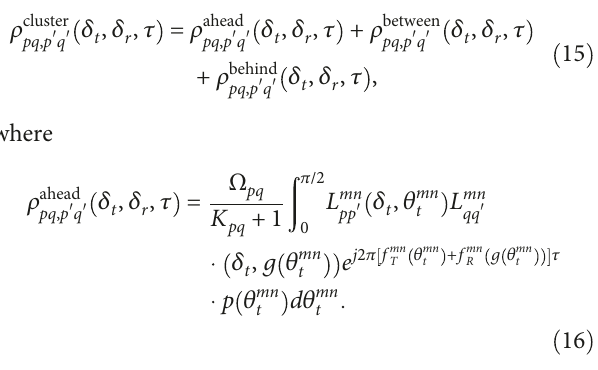
Figure 3: The measurement GPS track in South Dakota, USA ( N : 44 ° 40 ′ 13 ″ ∼ 44 ° 50 ′ 30 ″ , W : − 101 ° 65 ′ 82 ″ ∼ − 103 ° 02 ′ 72 ″